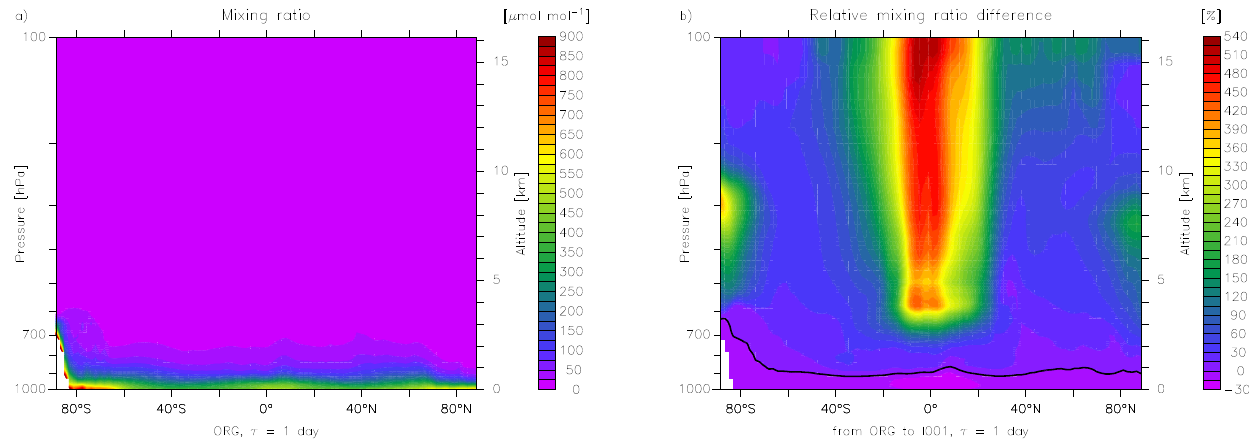
Figure 2. Decaying scalar with a lifetime of 1day, averaged zonally and over 2001. Shown are (a) the distribution for the ORG numerical experiment and (b) the relative mixing ratio difference for I001 compared to ORG.